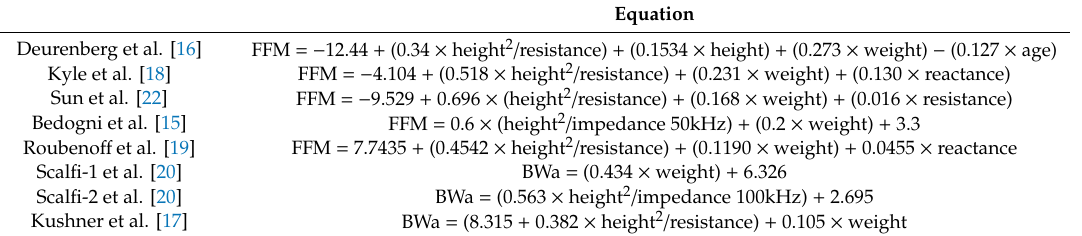
Table 1. Tested bioimpedance equations for body composition.